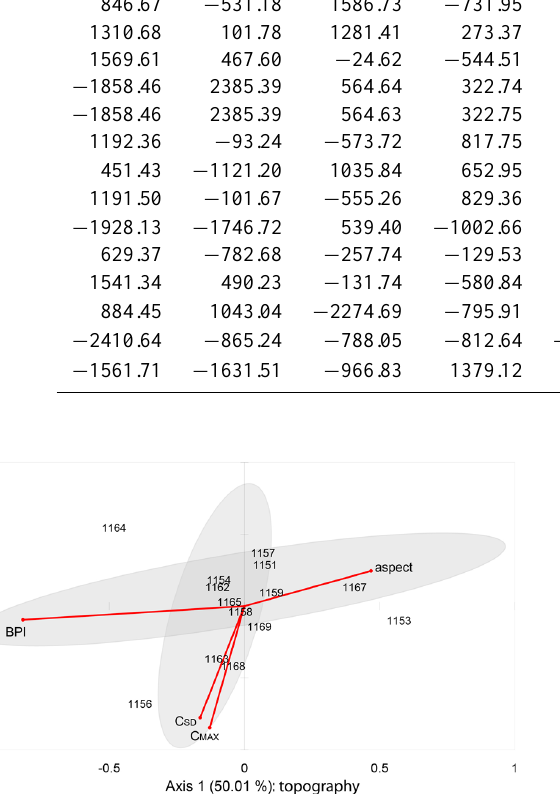
Table 2. Spatial eigenfunctions representing scales of positive autocorrelation detected in communities across the reef complex. A reduced set of five eigenfunctions (* broad-scale, ** fine-scale) explained much of the variation in assembly. Eig1 *Eig2